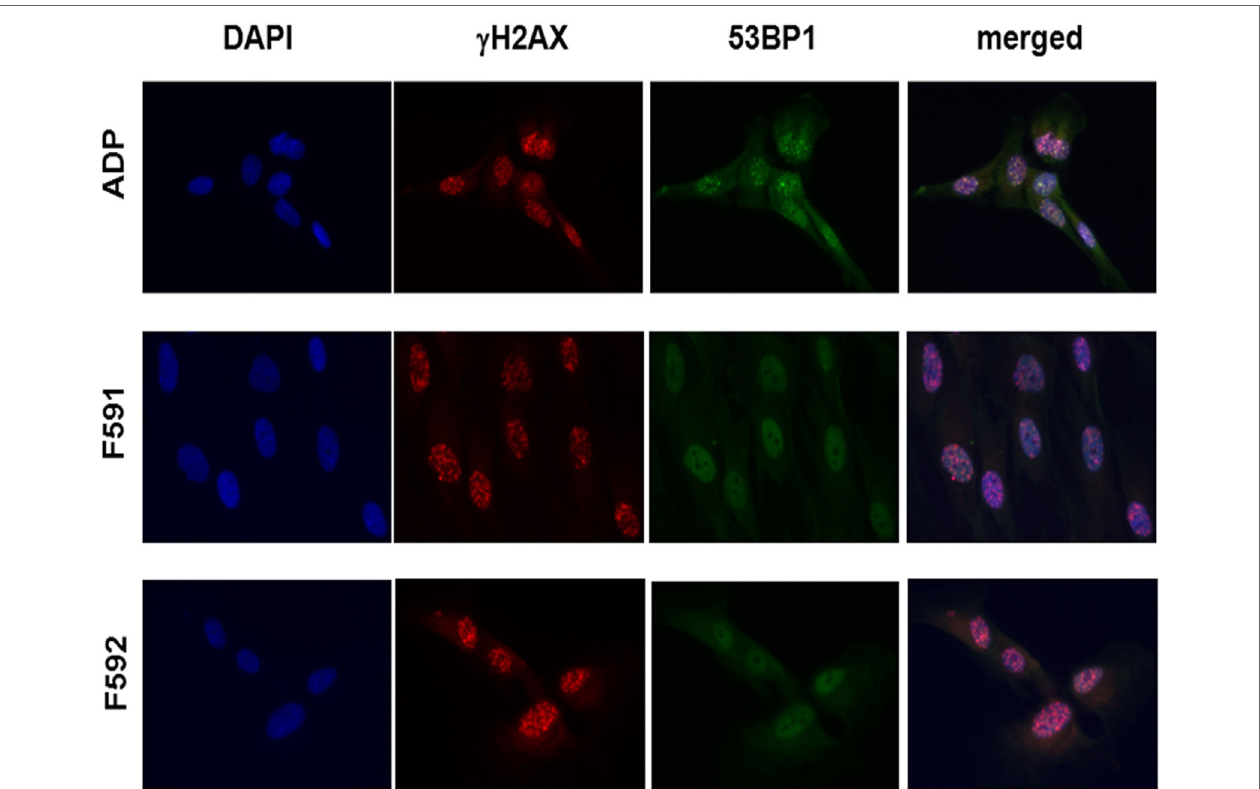
FigUre 3 | Immunocytochemical analysis of irradiation-induced repair foci in RNF168-deficient fibroblasts and lymphoblastoid cell lines. Detection of γ H2AX foci (second column) and 53BP1 foci (third column) in reference ADP fibroblasts (upper panel) compared to patient fibroblasts F591 and F592 (middle and bottom panel) at 1 h after 6 Gy irradiation. DAPI staining and merged pictures are shown in the outer columns as controls for intracellular